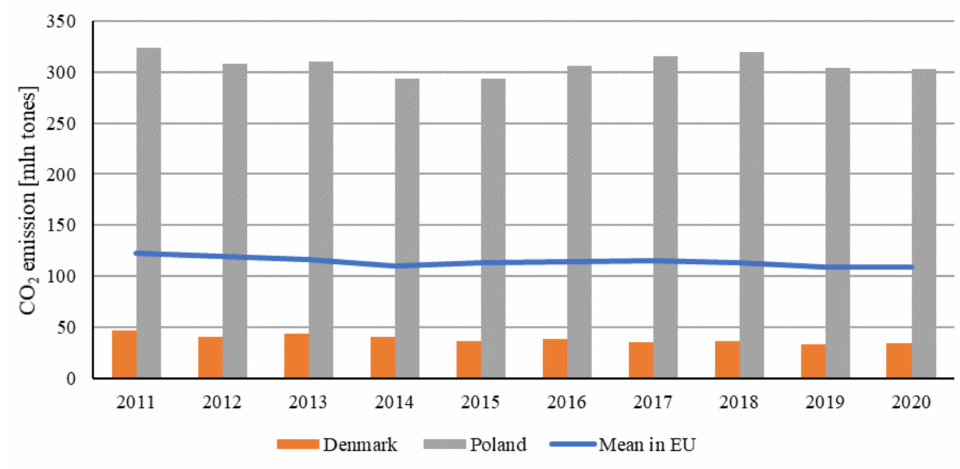
Figure 1. Greenhouse gas emissions in the European Union in